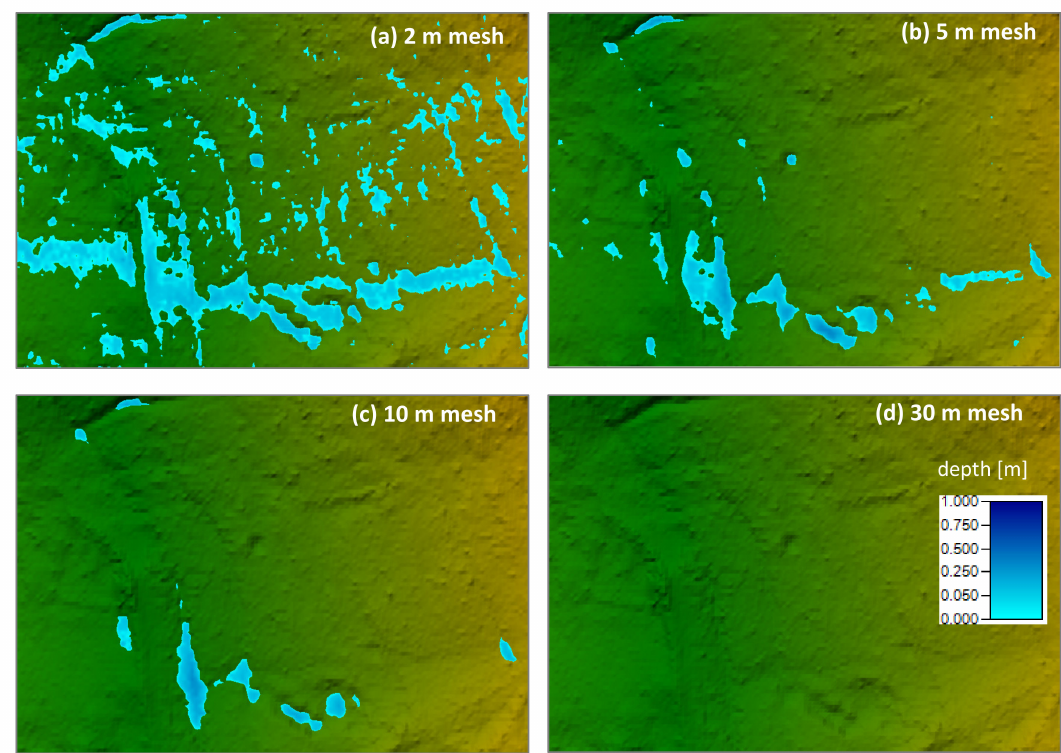
Figure 17. Qualitative comparison of flooded area (max. flood depth during overall simulation time) for four different mesh resolution ( a ): 2 m, ( b ): 5 m, ( c ): 10 m, ( d ): 30 m and 1 m